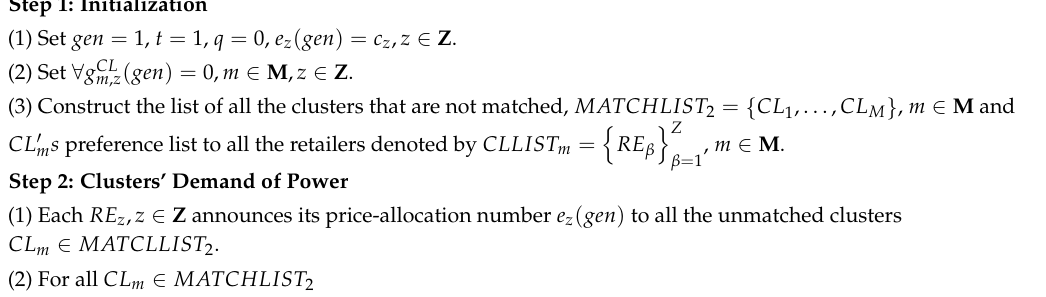
Algorithm 1 The bilaterally matching algorithm between the retailers and the